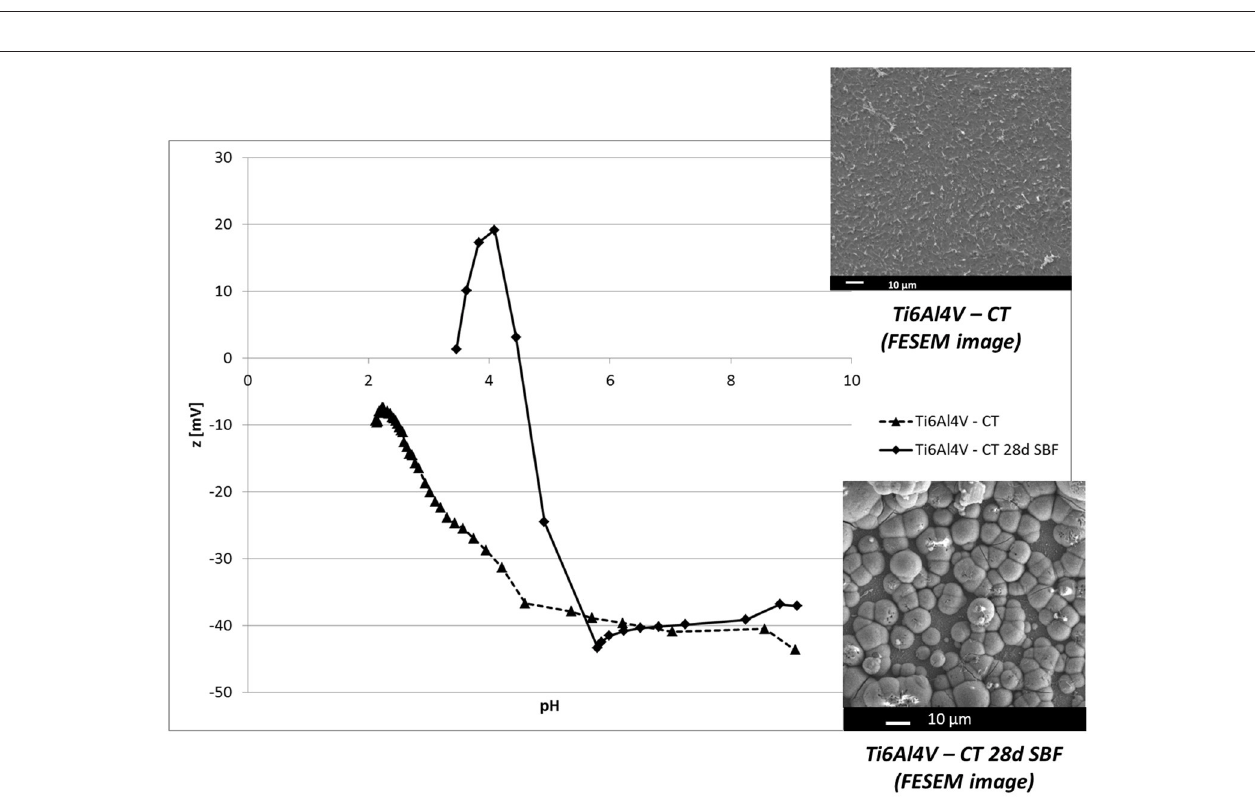
FIGURE 4 | Zeta potential vs. pH of Ti6Al4V – CT and Ti6Al4V – CT after 28 in SBF. Inserts: FESEM image of Ti6Al4V – CT before and after 28 days in SBF (apatite deposition).